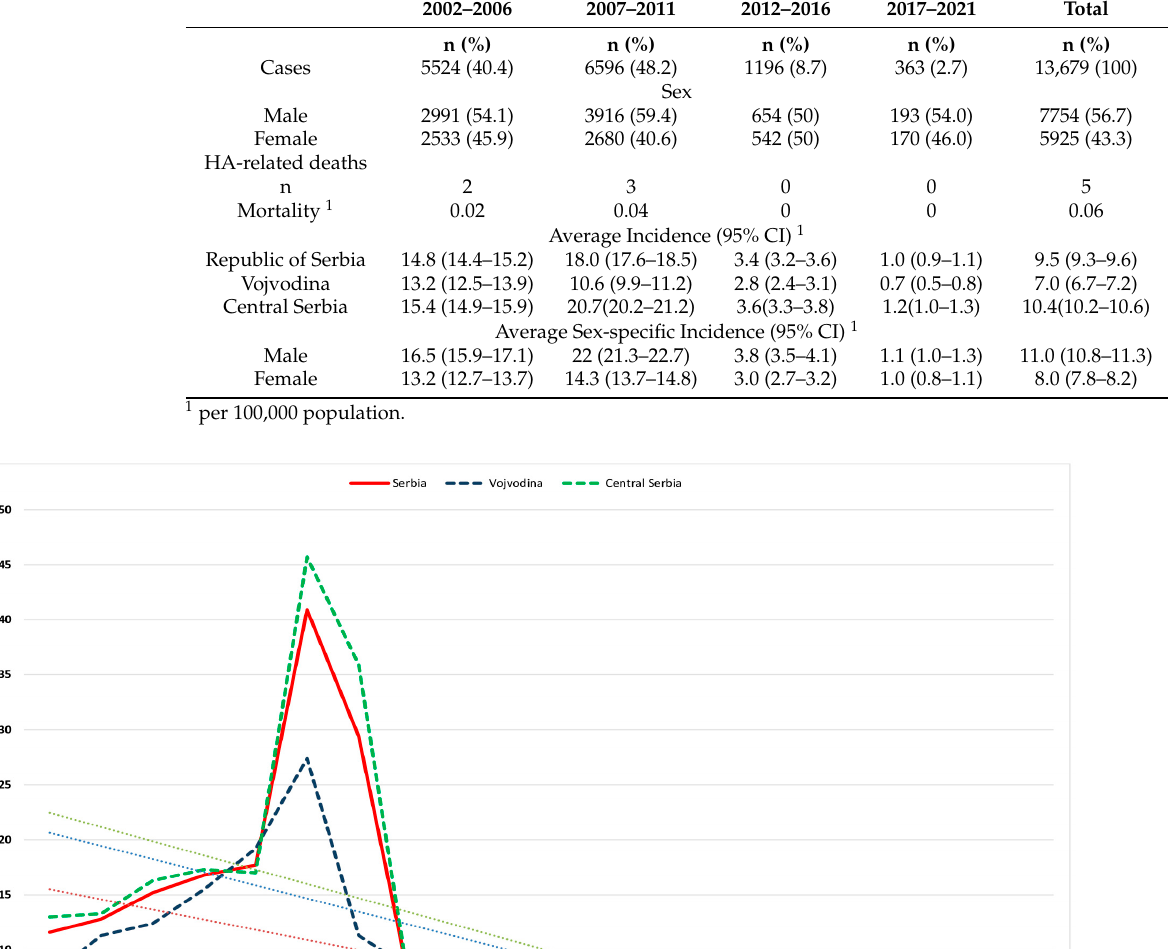
Table 1. Hepatitis A notification data in Serbia, 2002–2021.